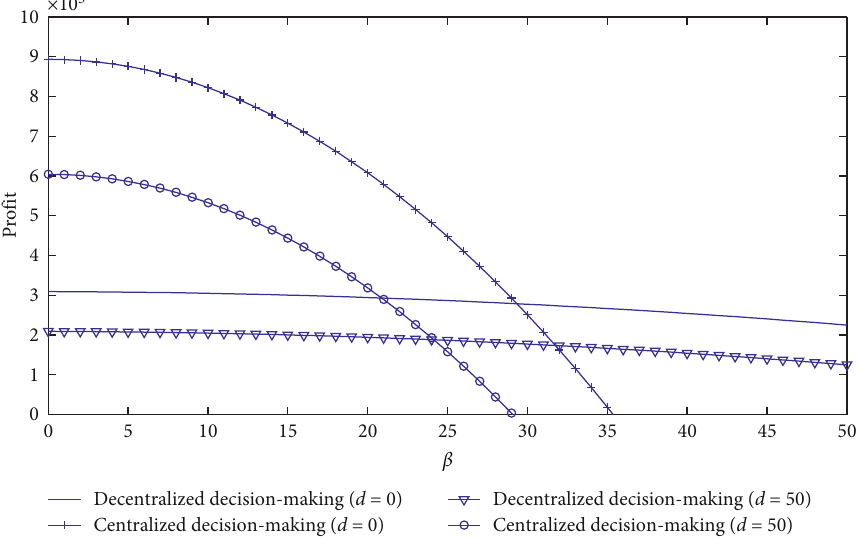
Figure 7: The impact of the competition coefficient on supply chain profit under decentralized and centralized decision-making.